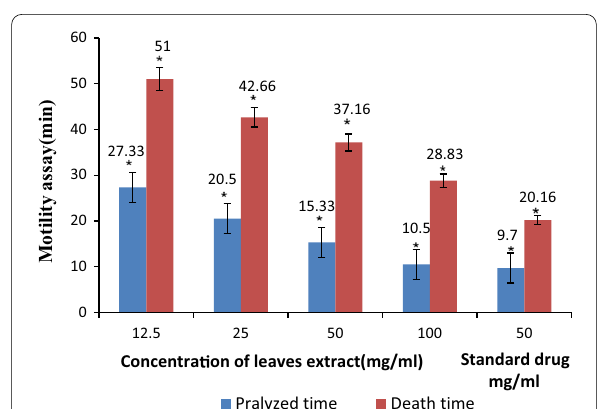
extract of P. minima which produces similar effects.